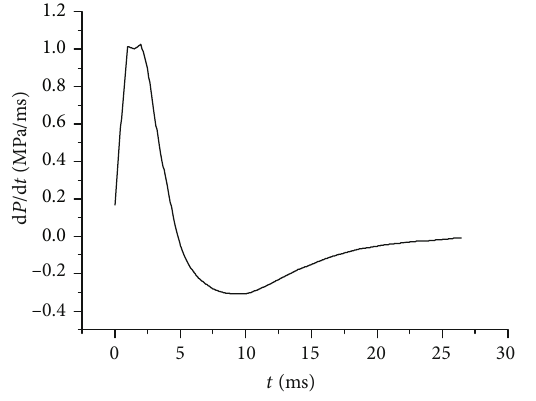
Figure 4: Derivative of pressure versus time.